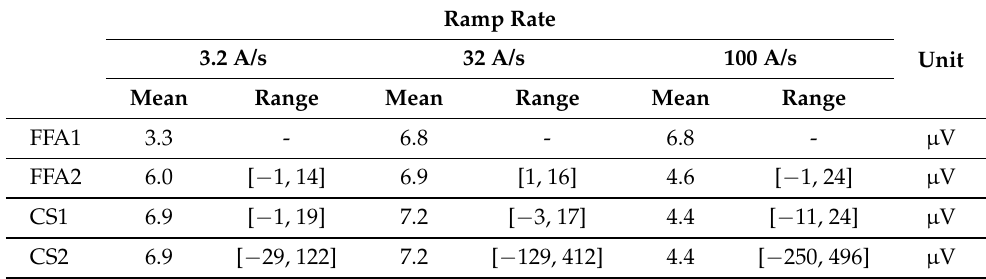
Figure 6. Estimated offset voltage values obtained by Kalman filtering (black), when the field values estimated from the excitation current are used in the measurement equation (case study 2), and the two feed-forward offset correction algorithms (FFA1 in blue, FFA2 in orange), plotted for comparison. The corresponding field values obtained by applying the different algorithms can be seen in Figure 7. Table 1. Mean and range of the estimated voltage offset v 0